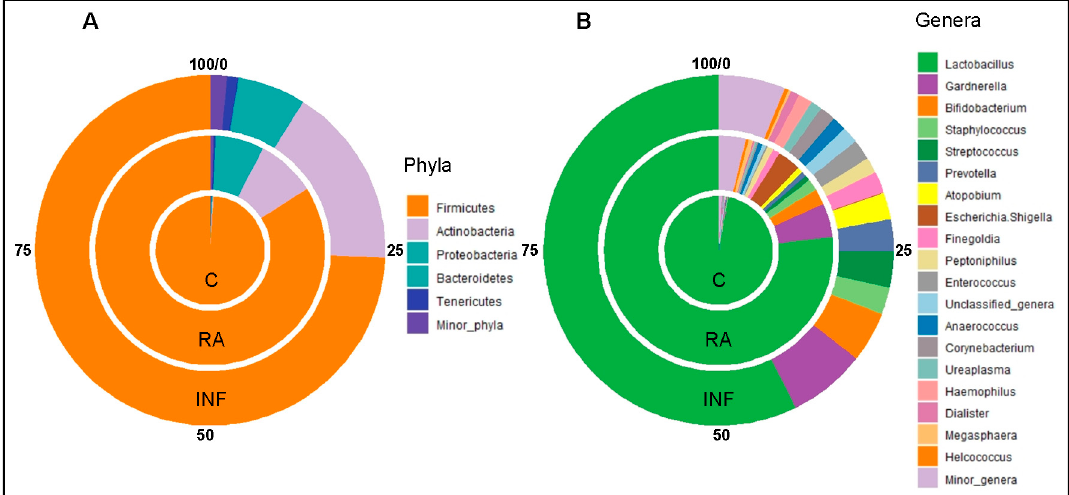
Figure 3. Pie charts showing the percentages of the relative abundances of the 5 most abundant phyla ( A ) and the 20 most abundant genera ( B ) in the CVL samples from healthy fertile women (inner pie charts; C group), women with a history of repetitive abortion (middle pie charts; RA group), and women with infertility of unknown origin (outer pie charts; INF group). Table 3. Relative frequencies, medians and interquartile range (IQR) of the most abundant bacterial phyla and genera detected in CVL samples from fertile women (Control group), women with a history of repetitive abortion (RA group), and women with infertility of unknown origin (INF group).